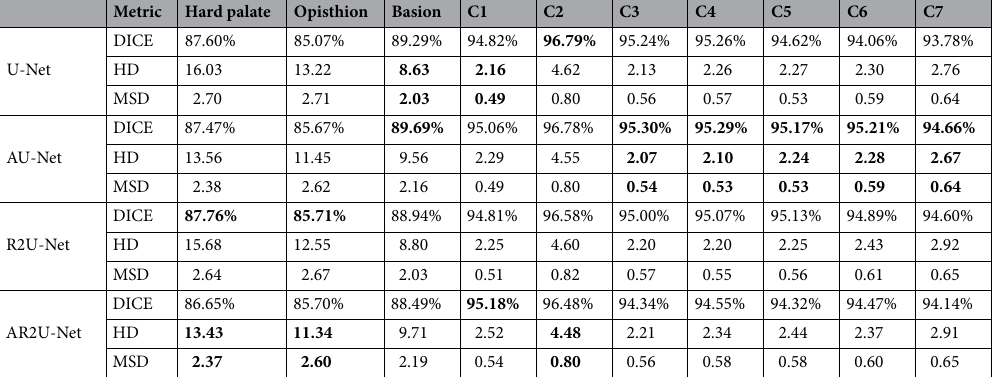
Table 2. Average dice coefficient values of each bone mask segmented by different U-Net models. Bolded numbers represent the largest DICE value, lowest HD and MSD